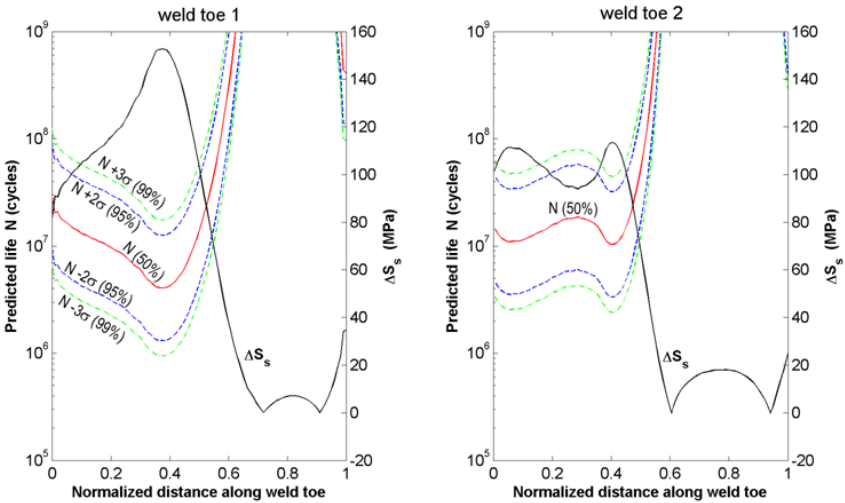
Figure 6: Life prediction (with different scatter bands) and equivalent structural stress range  S s for the weld toes in Fig. 3.